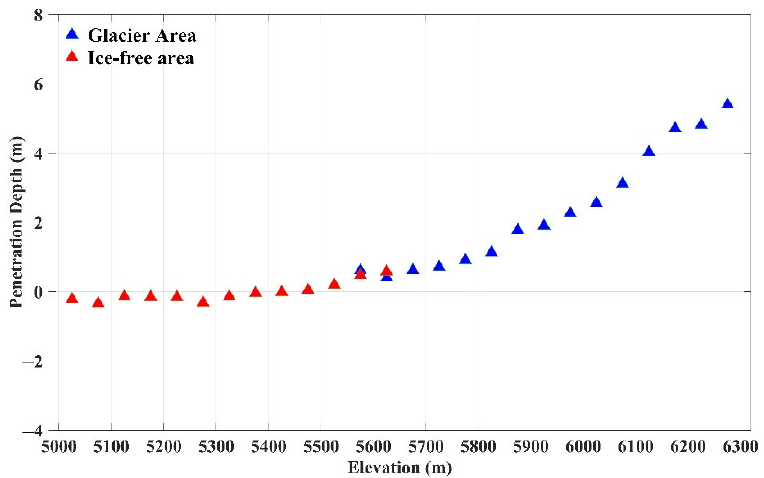
Figure 3. The distribution of radar penetration depths according to altitude. The penetration depths were measured by differencing the SRTM ‐ X and SRTM ‐ C DEMs.